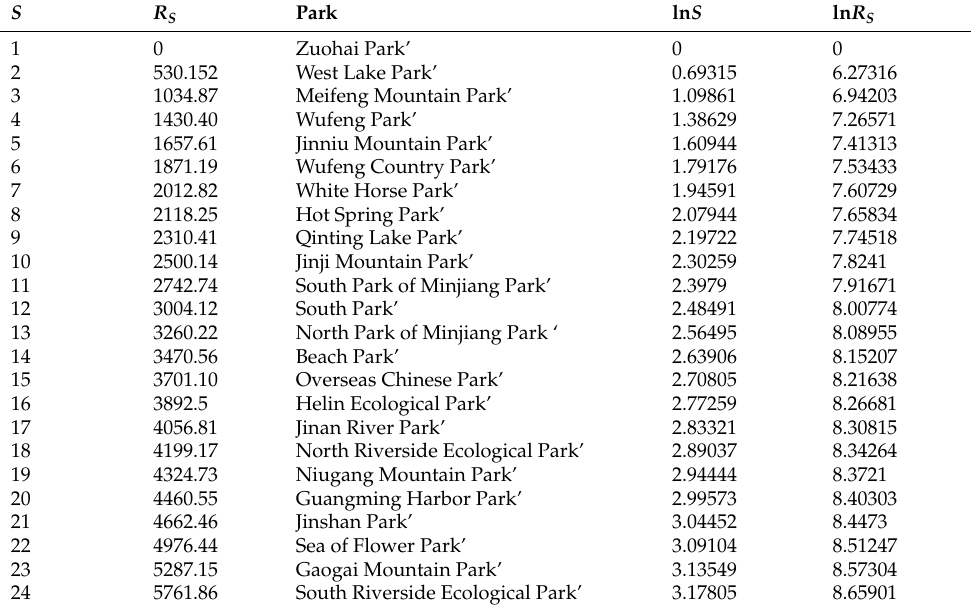
Table A2. Park system aggregation dimensions based on Zuohai